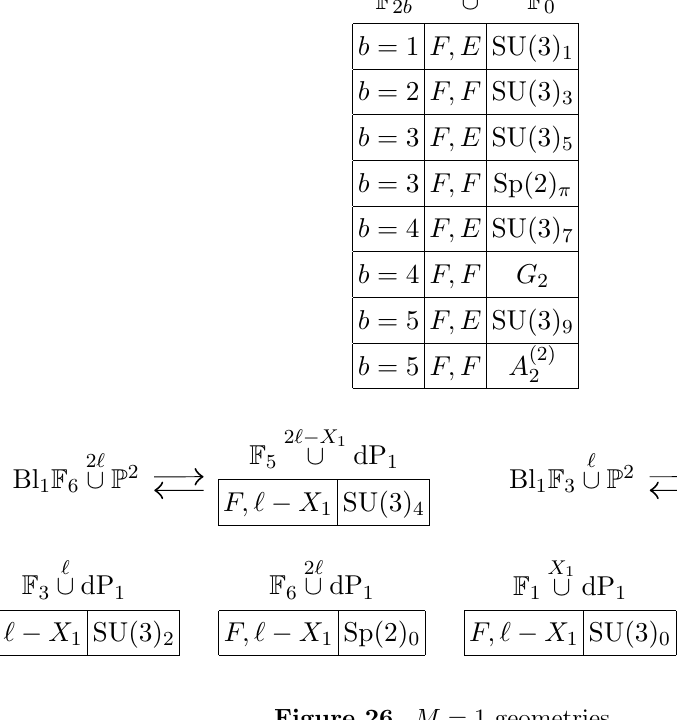
Figure 26. M = 1 geometries.